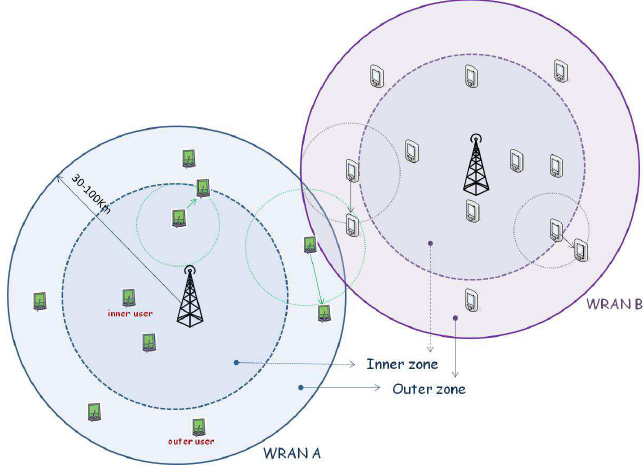
Figure 1. Interference among CPEs of overlapped WRANs.